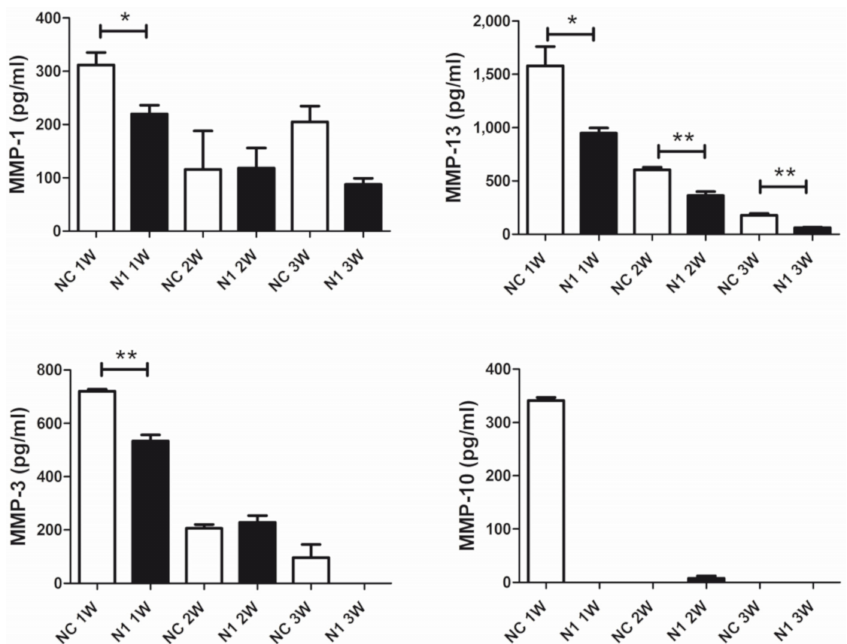
Figure 6. Effects of NOTCH1 silencing in the repertoire of MMPs released by chondrocytes cultured in 3-D. A representative patient out of four analyzed. Data are relative to triplicate micromasses at 1, 2, and 3 week maturation and are expressed as mean ± standard error of mean. Statistical analysis was performed by Student’s t test; * p < 0.05, ** p <